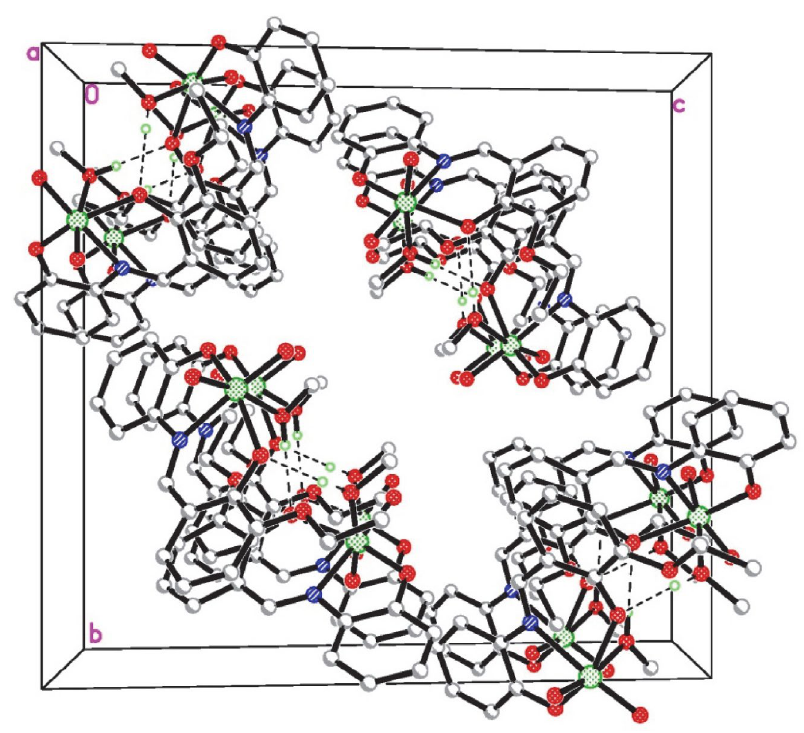
Figure 4. The hydrogen bonds (dashed lines) linked dimeric structure of complex 2 , viewed along the a axis.